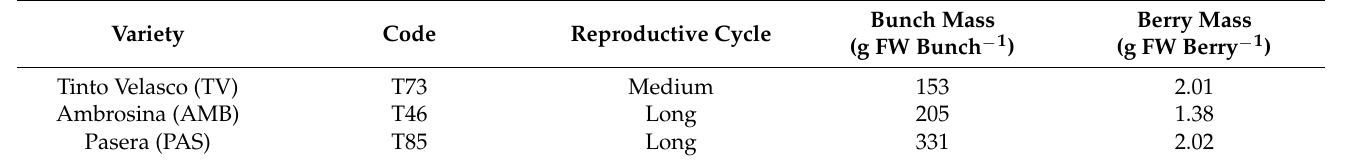
Table 4. Agronomic characteristics of Spanish autochthonous grapevine ( Vitis vinifera L.) varieties used in present study. Data were provided by Estaci ó n de Viticultura y Enolog í a de Navarra (Olite, Spain) and obtained from plants cultivated in vineyard in 2019. FW = fresh